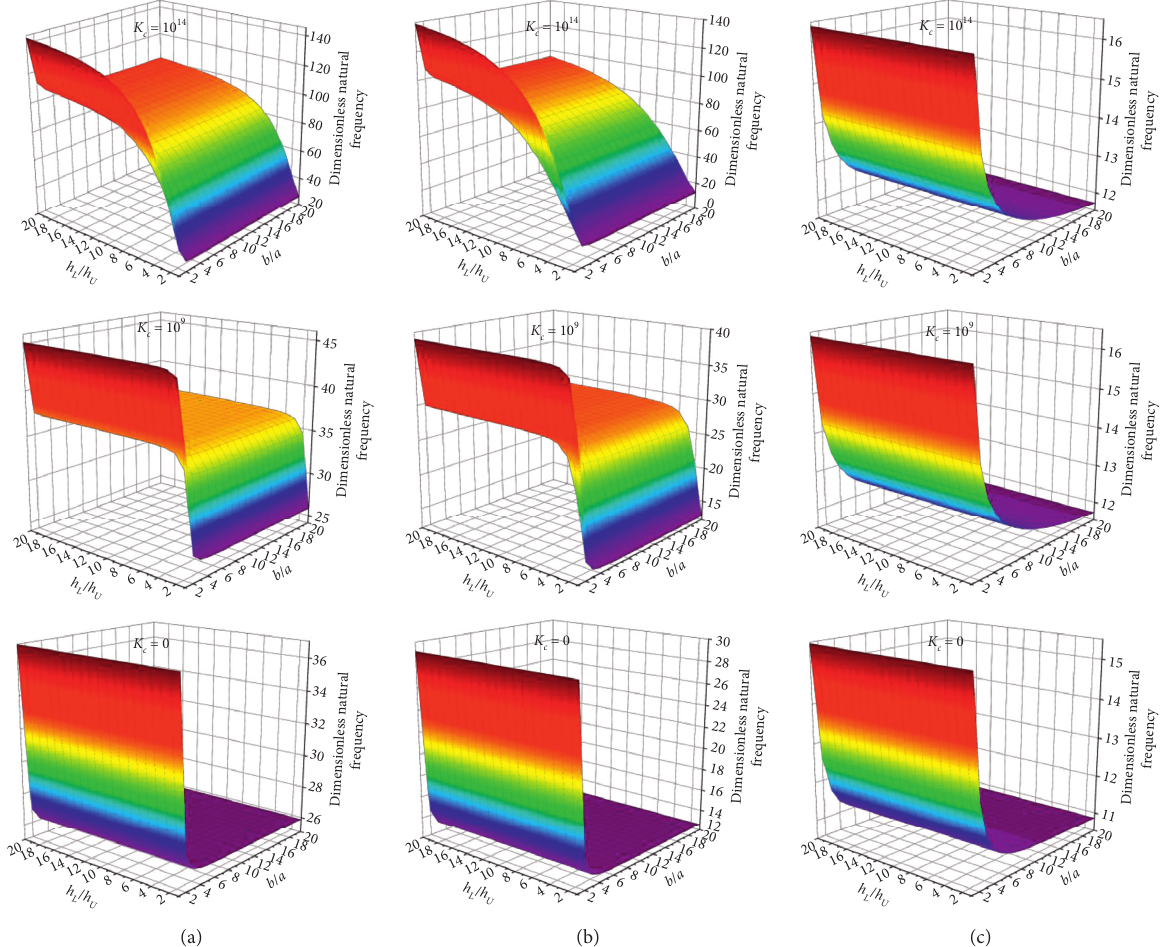
Figure 9: Variation of dimensionless natural frequency versus length-width ratio for an LCDPS with different conditions. (a) CCCC-CCCC; (b) SSSS-SSSS; (c) E 1 E 1 E 1 E 1